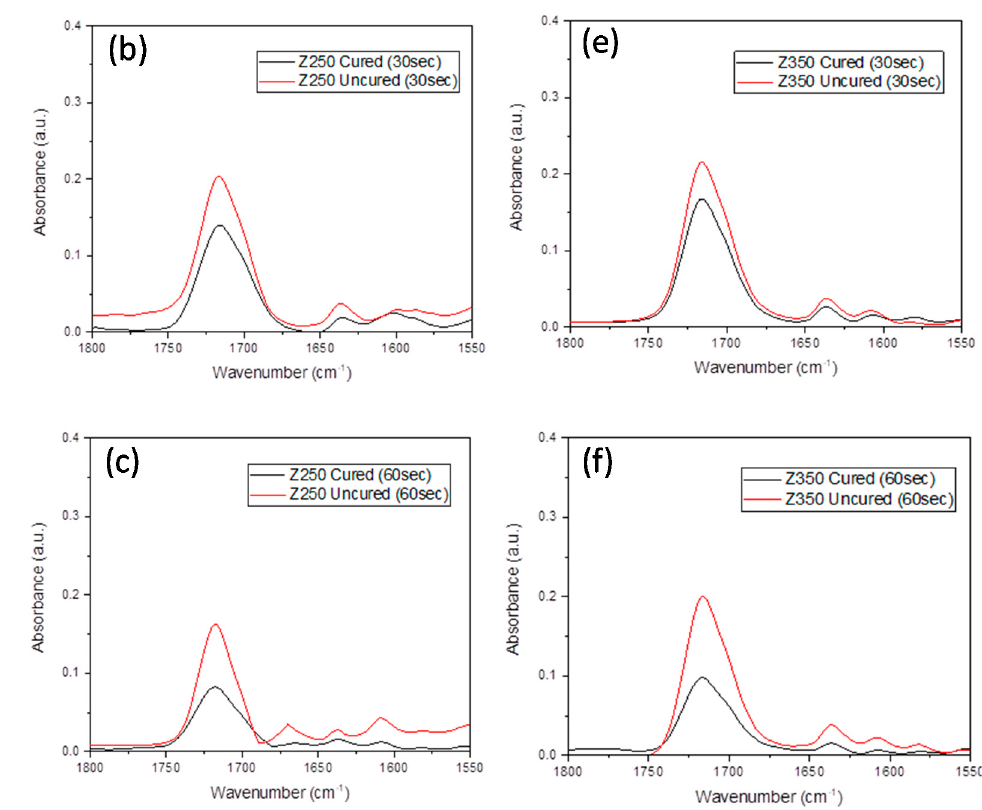
Figure 3. Comparative FTIR spectra of uncured and cured Filtek Z250 composite ( a ) without ultra- sonic application, ( b ) 30 s ultrasonic application, and ( c ) 60 s ultrasonic application. The comparative FTIR spectra of cured and cured Filtek Z350 composite ( d ) without ultrasonic application, ( e ) 30 s ultrasonic application, and ( f ) 60 s ultrasonic application. The change in intensity was observed at 1715 cm − 1 (C=O), 1635 cm − 1 (aliphatic), and 1602 cm − 1 (aromatic).